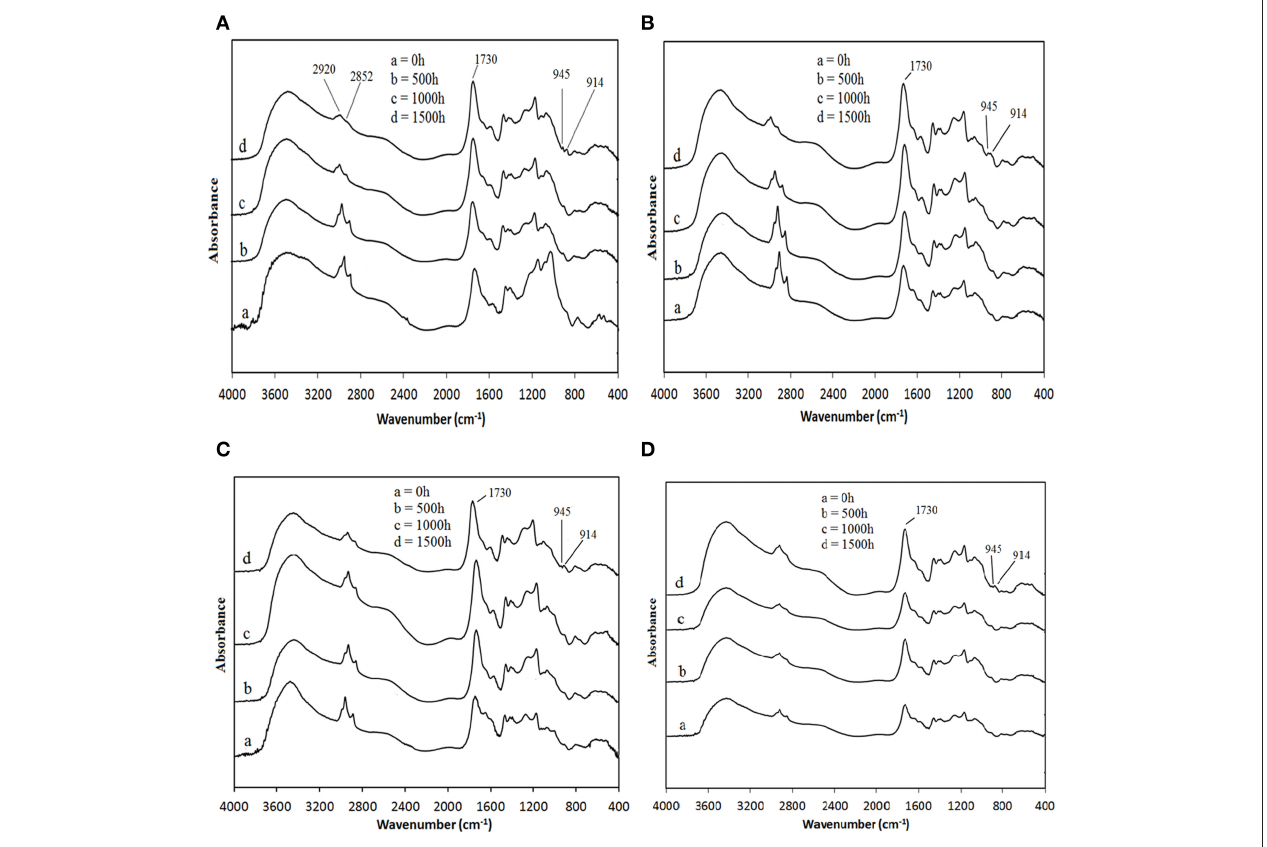
FIGURE 2 | FT-IR spectra of composites during weathering exposure (A) UTKC, (B) ATKC, (C) AHTKC, and (D) HTKC.